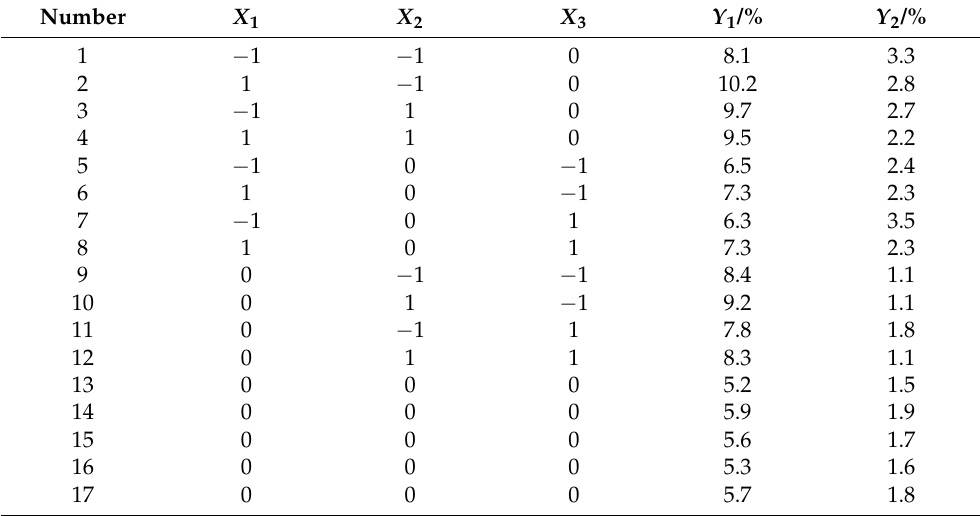
Table 2. Test design and response